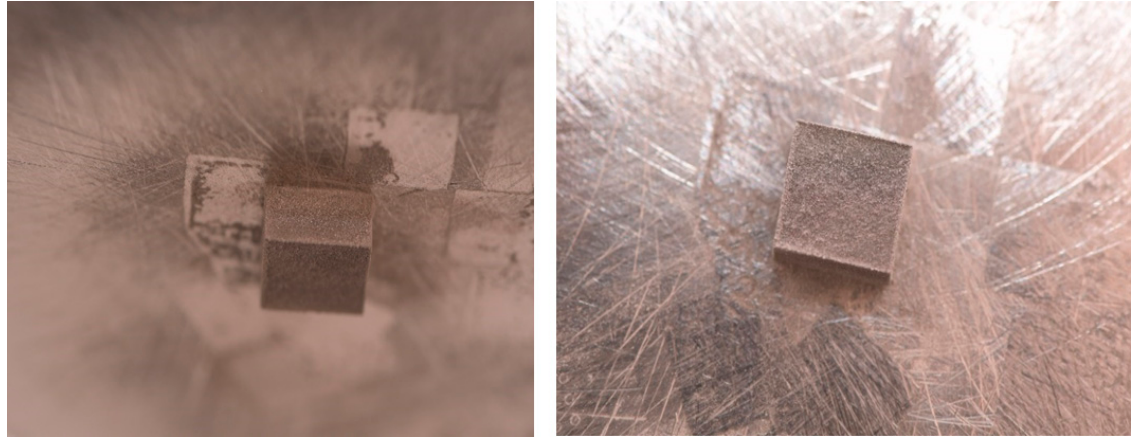
Figure 14. The sample of Mg-10Zn-0.8Ca-0.5Zr alloy-powder processed by SLM—two macro images of the same sample.